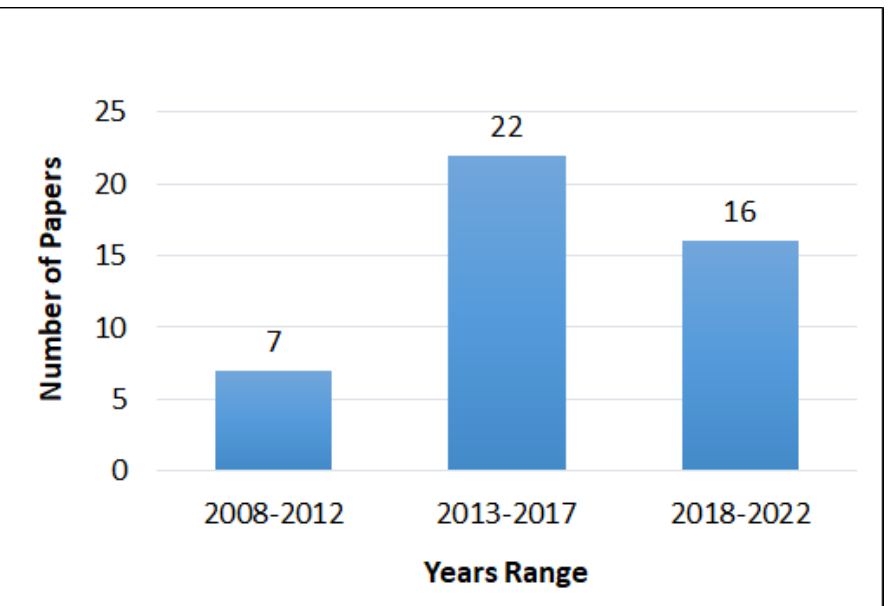
Figure 7. The publication year of the surveyed papers.